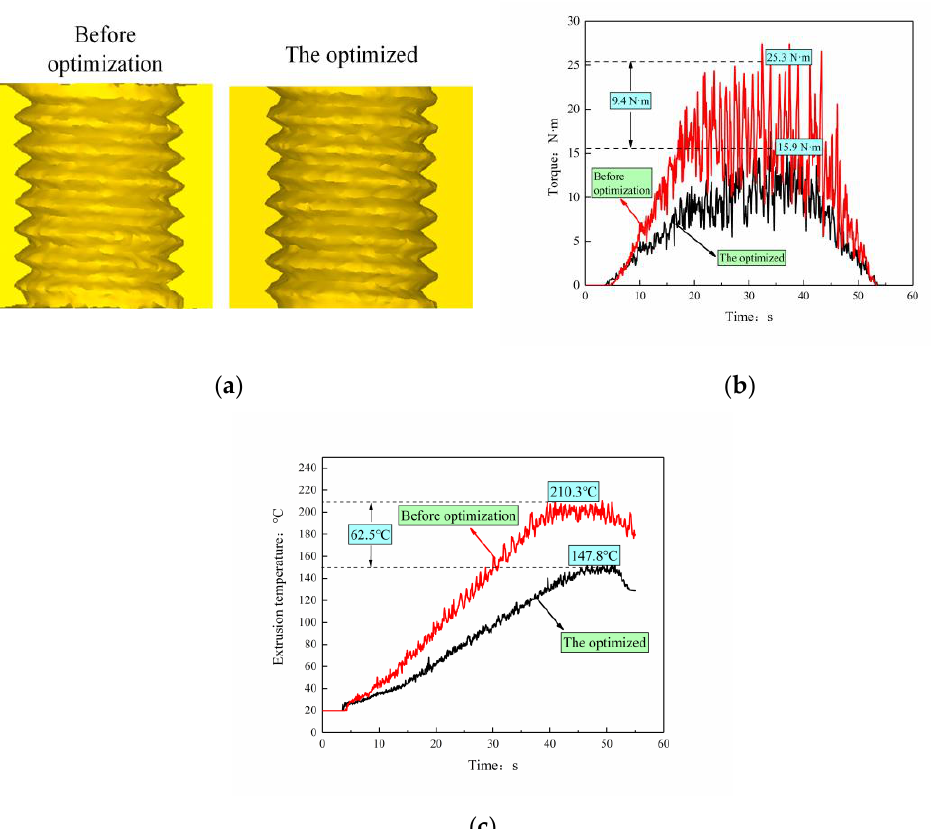
Figure 10. Comparison before and after optimization: ( a ) Extrusion profile, ( b ) Extrusion torque, ( c ) Extrusion temperature.